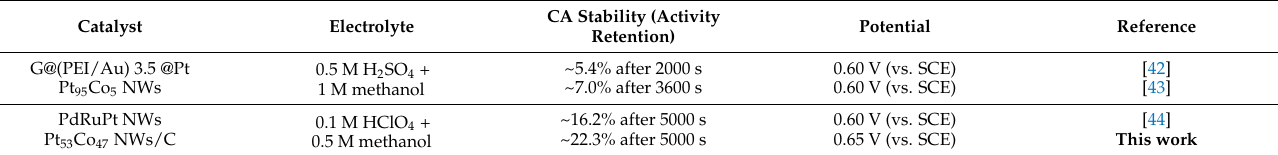
Table 4. Stability comparison of Pt 53 Co 47 NWs/C and Pt-based electrocatalysts for